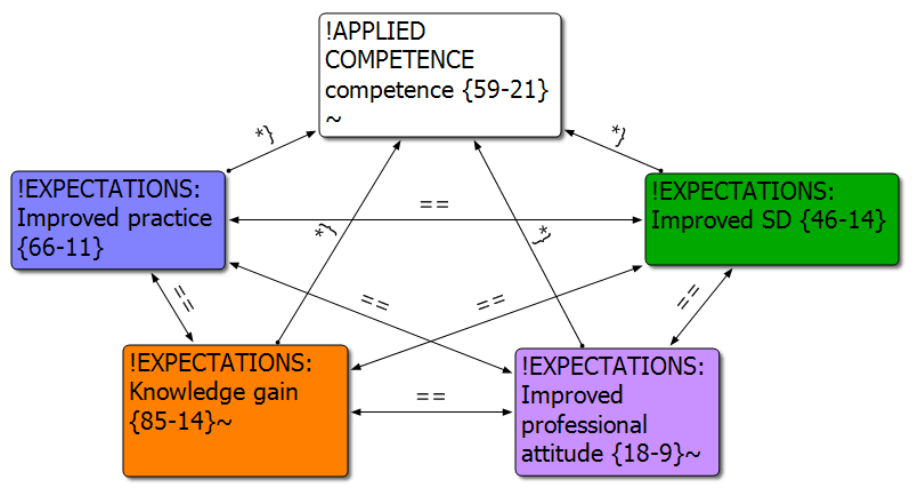
Figure 2 . Expectations for the way the programme will support applied competence.